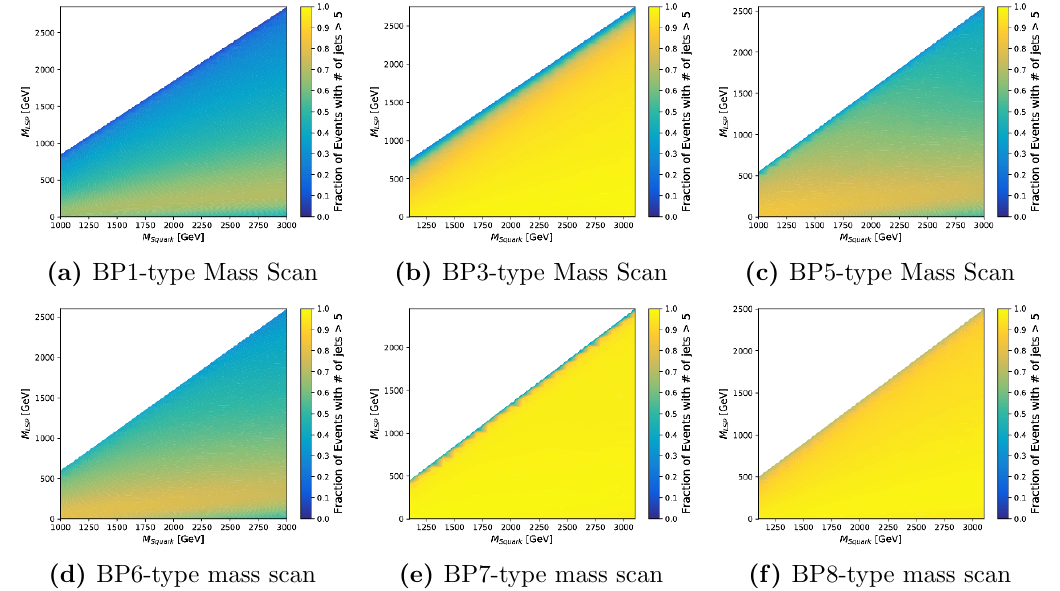
Figure 10. Fraction of events with total number of hadronic jets > 5 for the BP1-BP8-type mass